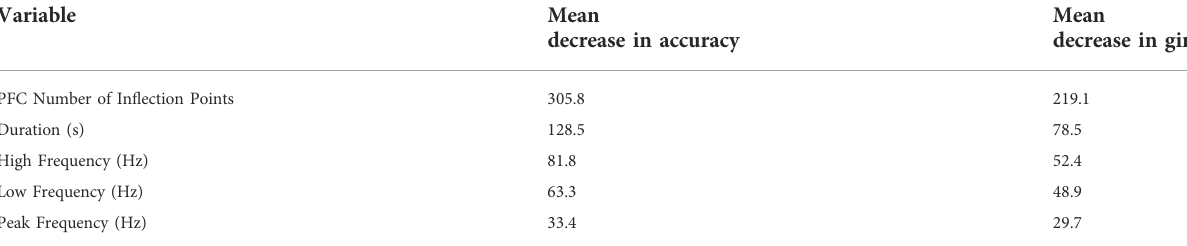
TABLE 3 Variable importance measures from Random Forest Analysis, in descending order. Mean decrease in accuracy measures and mean decrease in Gini effectively describe variable importance.